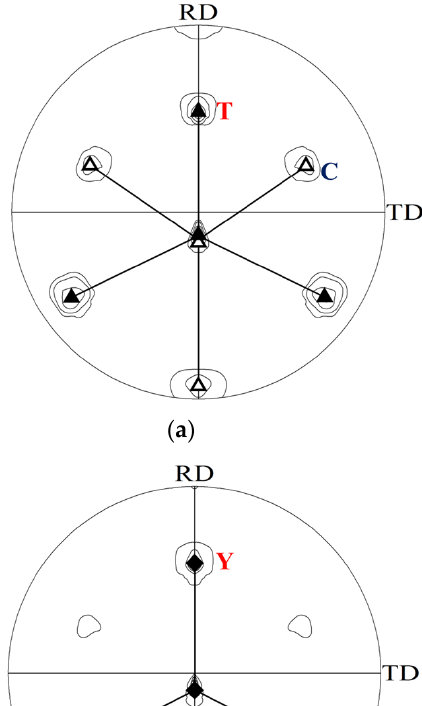
Figure 7. The {1 1 1} pole figures of fcc metals simulated using MTCS-model with single C orientation after the reduction ratios of ( a ) 30%, ( b ) 60%, and ( c ) 90%. (cid:52) , (cid:78) , and (cid:117) are the pole positions on {1 1 1} pole figure of the orientation close to C ( 1 1 2 )